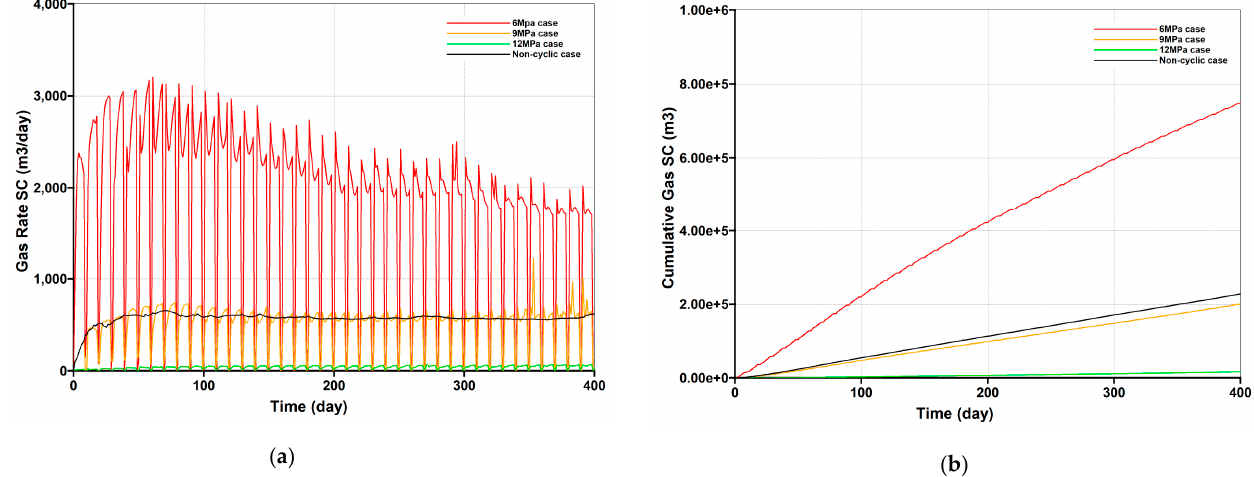
Figure 9. Results of gas production by use of different bottomhole pressure during primary depressurization stage: ( a ) gas production rate and ( b ) cumulative gas production.